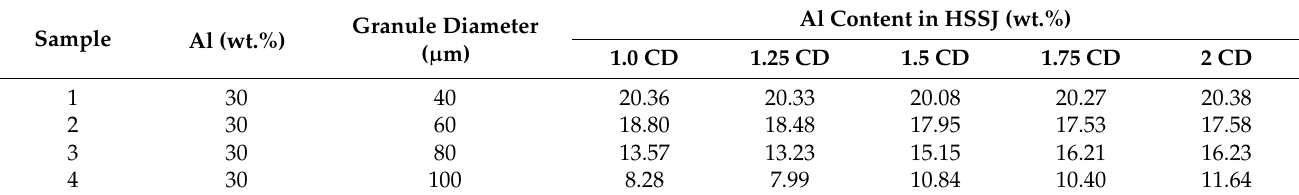
Table 3. List of computation conditions and